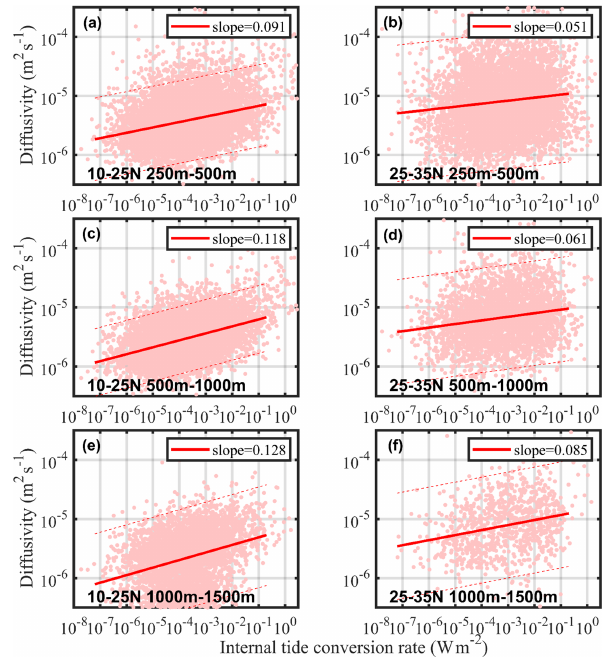
Figure 7. Scatterplot of log-scale K z versus log-scale internal tide conversion rate at 250–500m (a, b) , 500–1000m (c, d) , and 1000– 15000m (e, f) , and the best fit slopes are denoted by the red line. Panels (a, c, e) and (b, d, f) are 10–25 ◦ N and 25–35 ◦ N latitude bands, respectively, and the 95% confidence interval is indicated by dashed